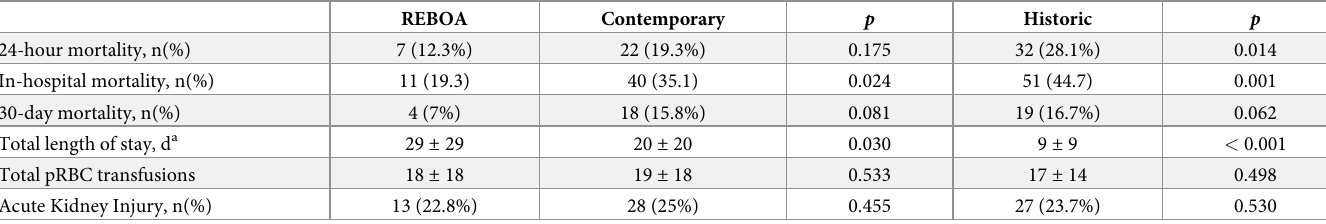
Table 3. Primary and secondary outcomes in REBOA and no-REBOA groups (contemporary and historic) � .